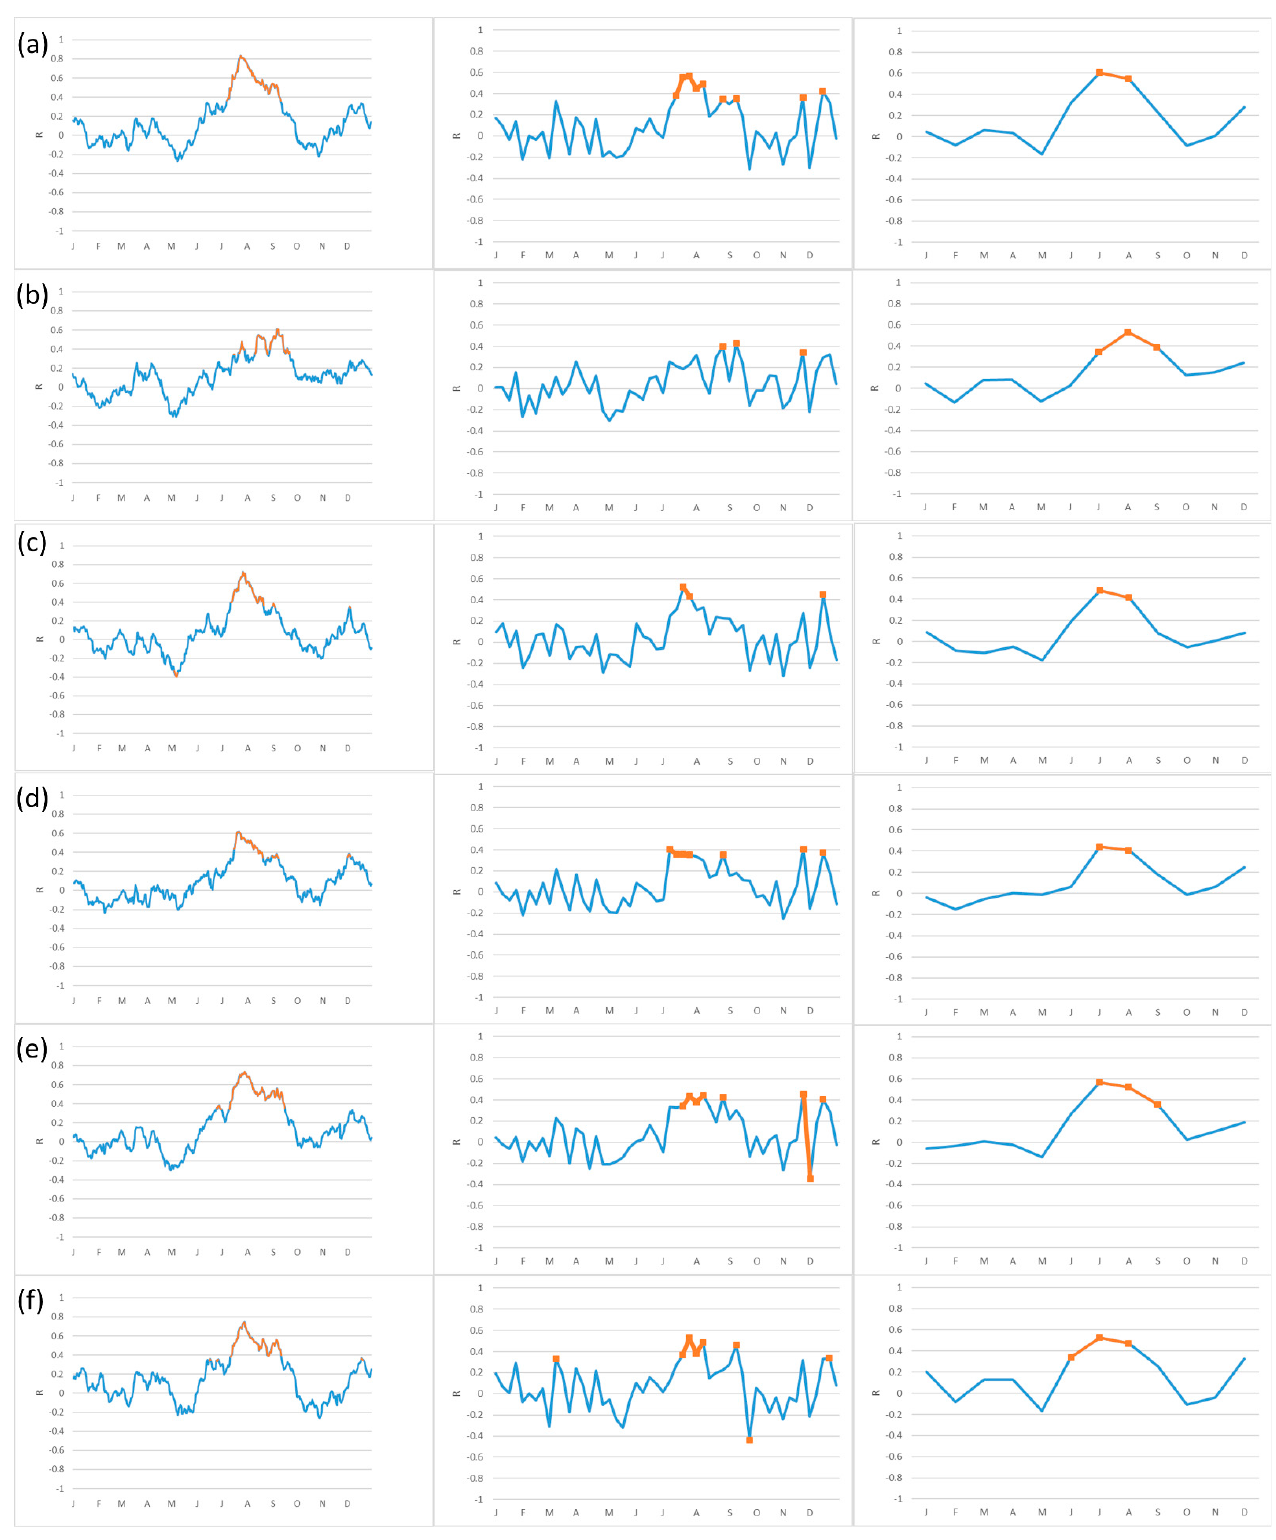
Figure 4. Temporal evolution of correlation coefficient values obtained with the samples-average approach between precipitation and black truffle production for daily data (left column), weekly data (middle column) and monthly data (right column). ( a ) Iberian Peninsula; ( b ) Betic Range; ( c ) Pyrenees; ( d ) North Iberian Range; ( e ) Central Iberian Range; ( f ) South Iberian Range. Orange points are R values with p value < 0.05.